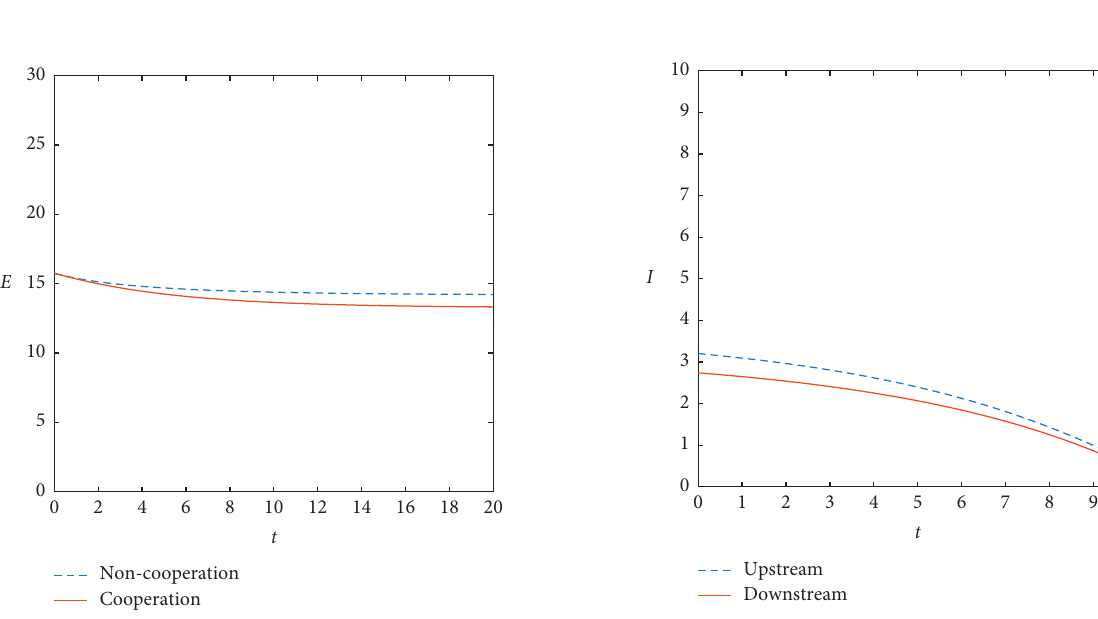
Figure 6: Optimal trajectory of pollution emission under coop- eration and non-cooperation when the planning period T ⟶ ∞ .